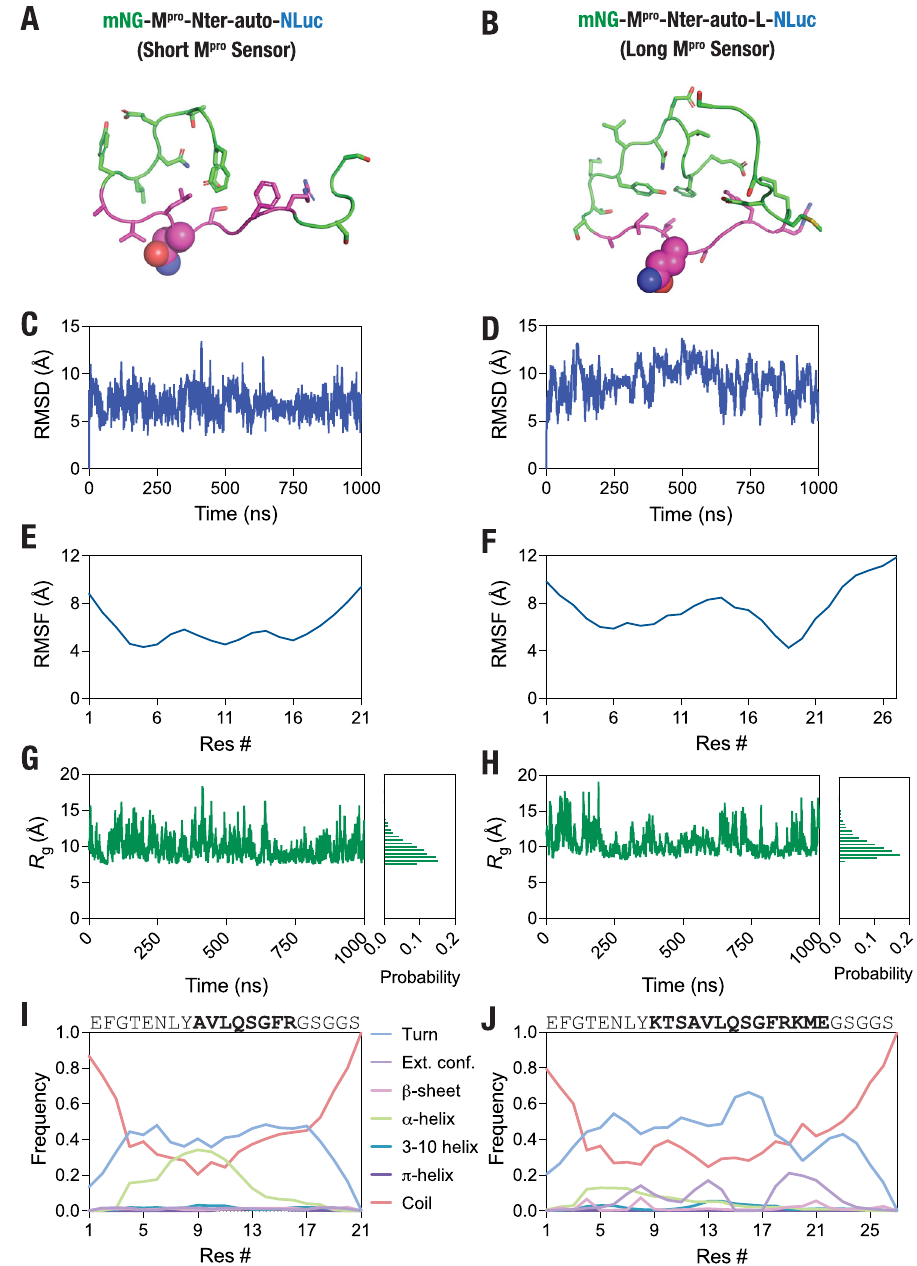
Fig. 2 M pro N-terminal autocleavage peptide is fl exible. A , B Cartoon representation of the M pro -Nter-auto (short; A ) and M pro -Nter-auto-L (long; B ) peptide structures modeled using the peptide substrate crystallized with H41A mutant SARS-CoV M pro (PDB: 2Q6G 68 ). C , D Graph showing backbone (C α ) root-mean-square deviation (RMSD) values of M pro -Nter-auto (short; C ) and M pro -Nter-auto-L (long; D ) peptide obtained from 1 μ s of GaMD simulations. E , F Graph showing backbone (C α ) root-mean-square fl uctuation (RMSF) values of M pro -Nter-auto (short; E ) and M pro -Nter-auto-L (long; F ) peptides. G , H Graph showing radius of gyration ( R g ) of the M pro -Nter-auto (short; G ) and M pro -Nter-auto-L (long; H ) peptides monitored over 1 μ s of GaMD simulations. I , J Graph showing frequency of the indicated secondary structures formed by the M pro -Nter-auto (short; I ) and M pro -Nter-auto-L (long; J ) peptides over the 1 μ s of GaMD simulations. T turn, E extended conformation, B isolated bridge, H α -helix, G 3-10 helix, I π -helix, C